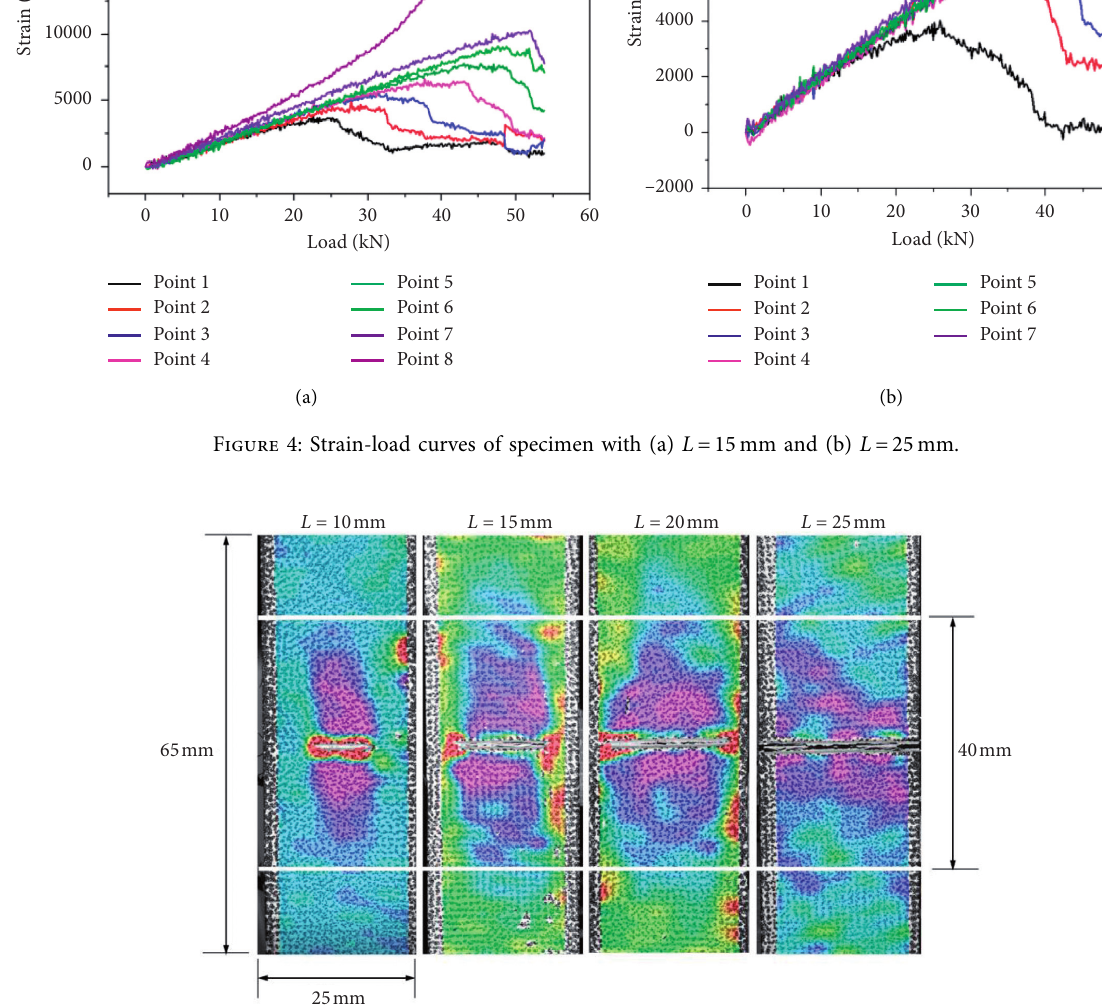
Figure 5: The strain fields under failure load.